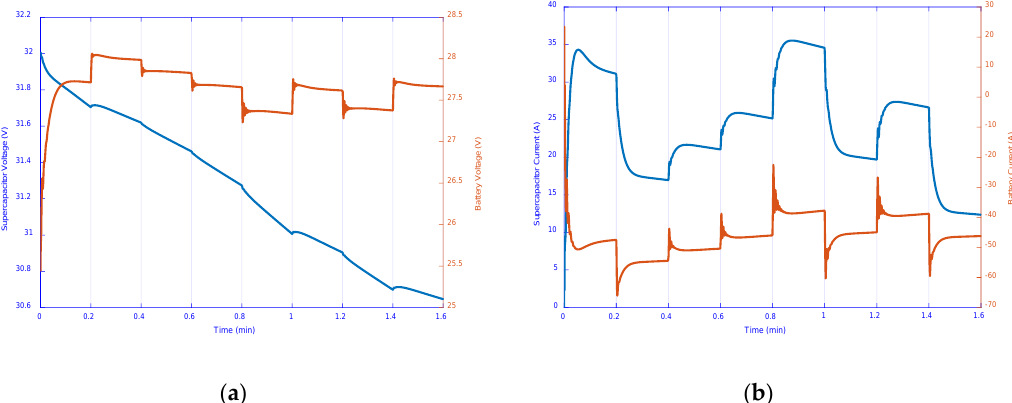
Figure 13. ( a ) Voltage and ( b ) Current the supercapacitor and battery.